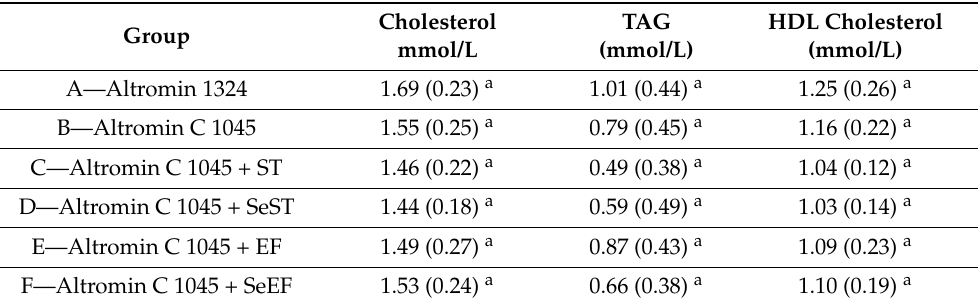
Table 4. Serum concentrations of the basic lipid parameters (mmol/L, n = 8). Data are presented as the mean (standard deviation). a –values in columns with the same superscript letter do not significantly differ ( p <